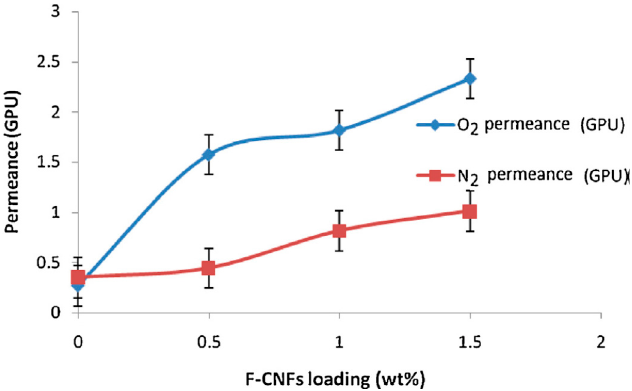
Figure 9. O 2 / N 2 separation performance of mixed matrix membranes as a function of carbon nanofiber (CNF) concentration (test conditions: 2 bar feed pressure gradient at ambient temperature).*All experimental data are reported as the average of at least three repeated measurements. (Reproduced with permission after